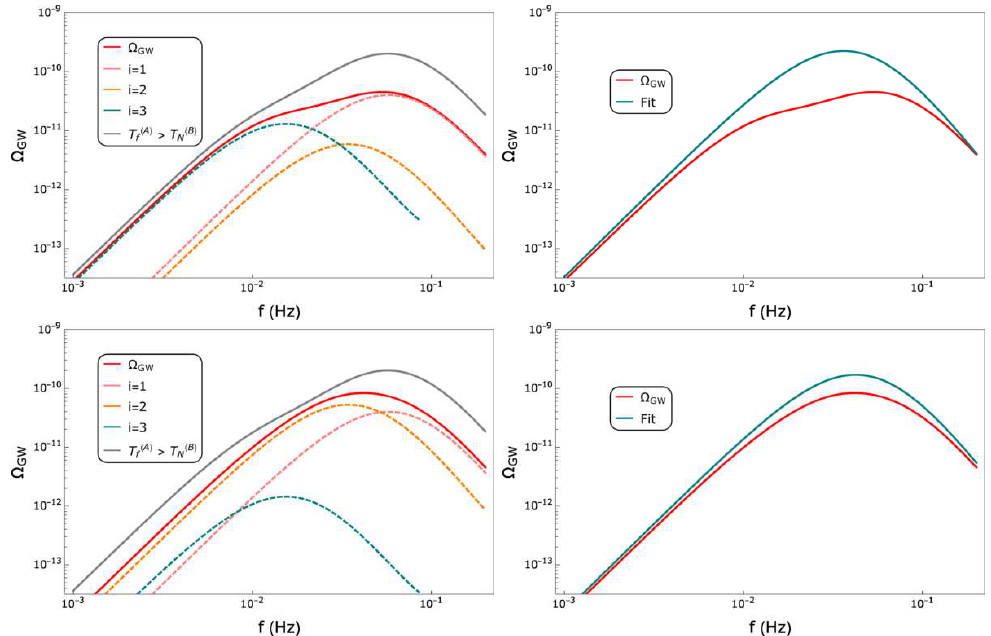
JHEP05(2018)210 Figure 4 . Left panels: the spectrum due to two simultaneous PTs, given by the red line, leads to a different spectrum than consecutive transitions. This can be seen by comparison with the gray line, which is predicted by the same thermal parameters, and w 1 = w 3 = 1, w 2 = 0. In the upper example we chose w 2 = 0 . 1 = 1 w 3 . In the lower example we chose w 2 = 0 . 9 = 1 w 3 . In both examples, − − w 1 = 0 . 2. Right panels: the spectrum from simultaneous PTs can not be fitted to the spectrum than from a single PT. Shown are fits to Ω GW in eq. (3.1) with Υ = 0 . 22, v w = 0 . 65, β/H = 124, T N = 134 GeV (upper panel), and Υ = 0 . 21, v w = 0 . 65, β/H = 142, T N = 136 GeV (lower panel). Figure 5 . For w 2 = w 3 = 0 . 5, the spectrum from simultaneous PTs can not be fitted to the spectrum of two single PTs. The comparison is to a fit of Ω GW = Ω ( A ) +Ω ( B ) with the parameters GW GW Υ = 0 . 094, v w = 0 . 65, β/H = 77 . 3, T N = 115 GeV (transition A), and Υ = 0 . 16, v w = 0 . 65, β/H = 179, T N = 133 GeV (transition B). The frequency band fitted and shown has been chosen such that Ω GW > 10 − 12